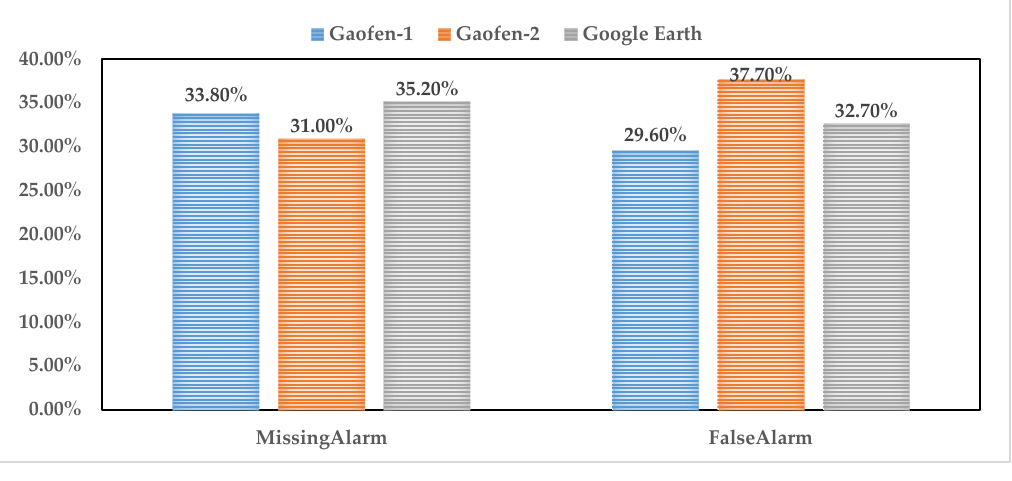
Table 2. Precision evaluation based on objects.